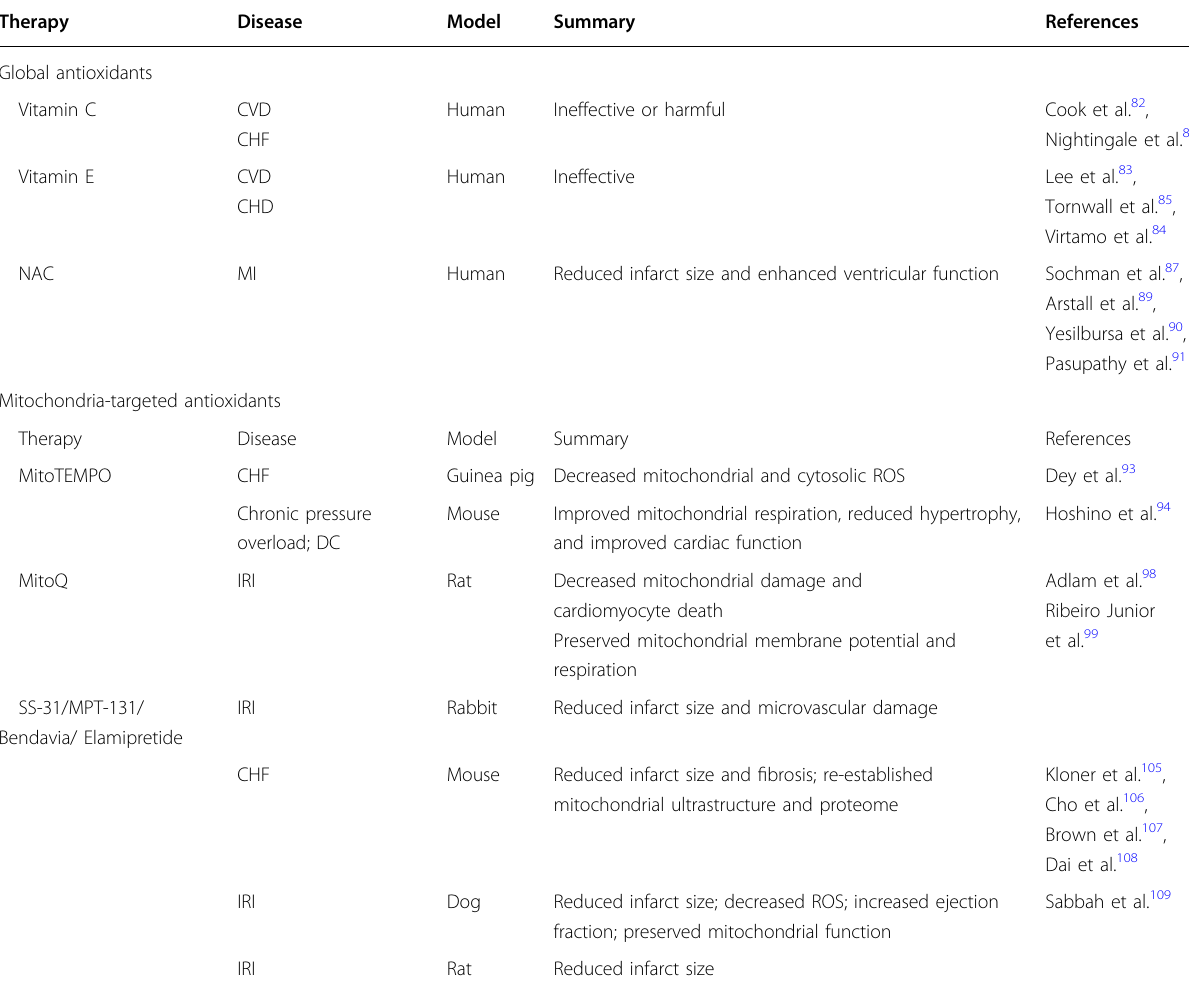
Table 2 Summary of selected antioxidant therapies for cardiovascular